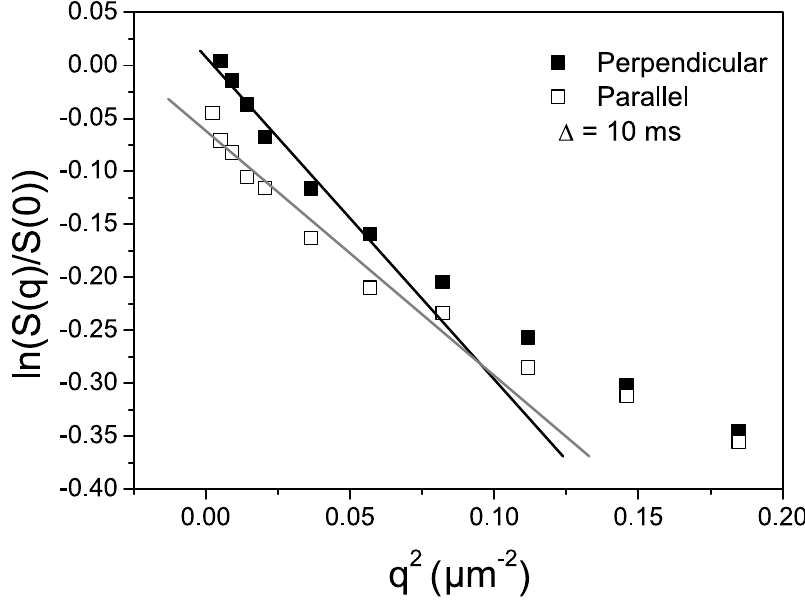
Figure 6. The dependence of the natural logarithm of normalized stimulated-echo amplitude as a function of q 2 for cSPEEK membrane crosslinked at 200 °C for 60 min, for two orientations of the membrane plane relative to the direction of the magnetic field